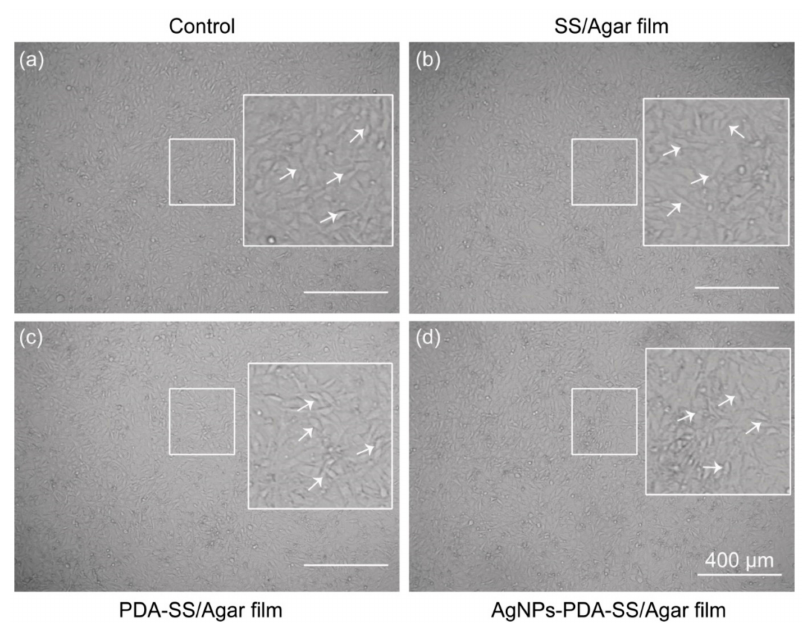
Figure 10. Microscopic observation of NIH/3T3 cells morphology with control ( a ), in the presence of SS/Agar film ( b ), PDA-SS/Agar film ( c ) and AgNPs-PDA-SS/Agar film ( d ). Small box represents a selected area, big box represents the enlarged image in the small box. White arrows indicate the observed fibroblast NIH/3T3 cells. The scale bar is 400 µ m.